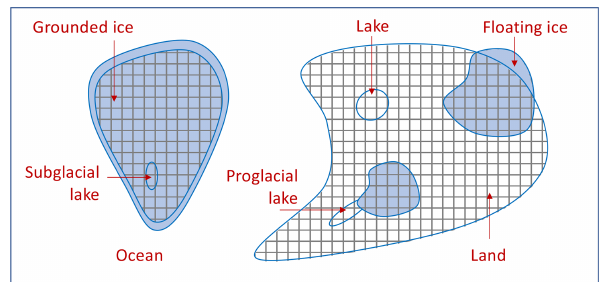
Figure 1. Conceptual depiction of land, ocean and ice domains in the Earth system. Gridded areas represent land and the rest rep- resents the ocean. Lakes are considered part of the land. Ice can have multiple domains, shown here with blue shading. The land– ocean boundary is generally defined as the coastline, which is called grounding line when it is part of the ice domain. Because our fo- cus is on grounding line migration in marine portions of an ice- sheet/shelf system, we assume that all of ice on land (gridded por- tions of blue shading) is grounded. Consequently, floatation of ice on subglacial and proglacial environments is not considered in this